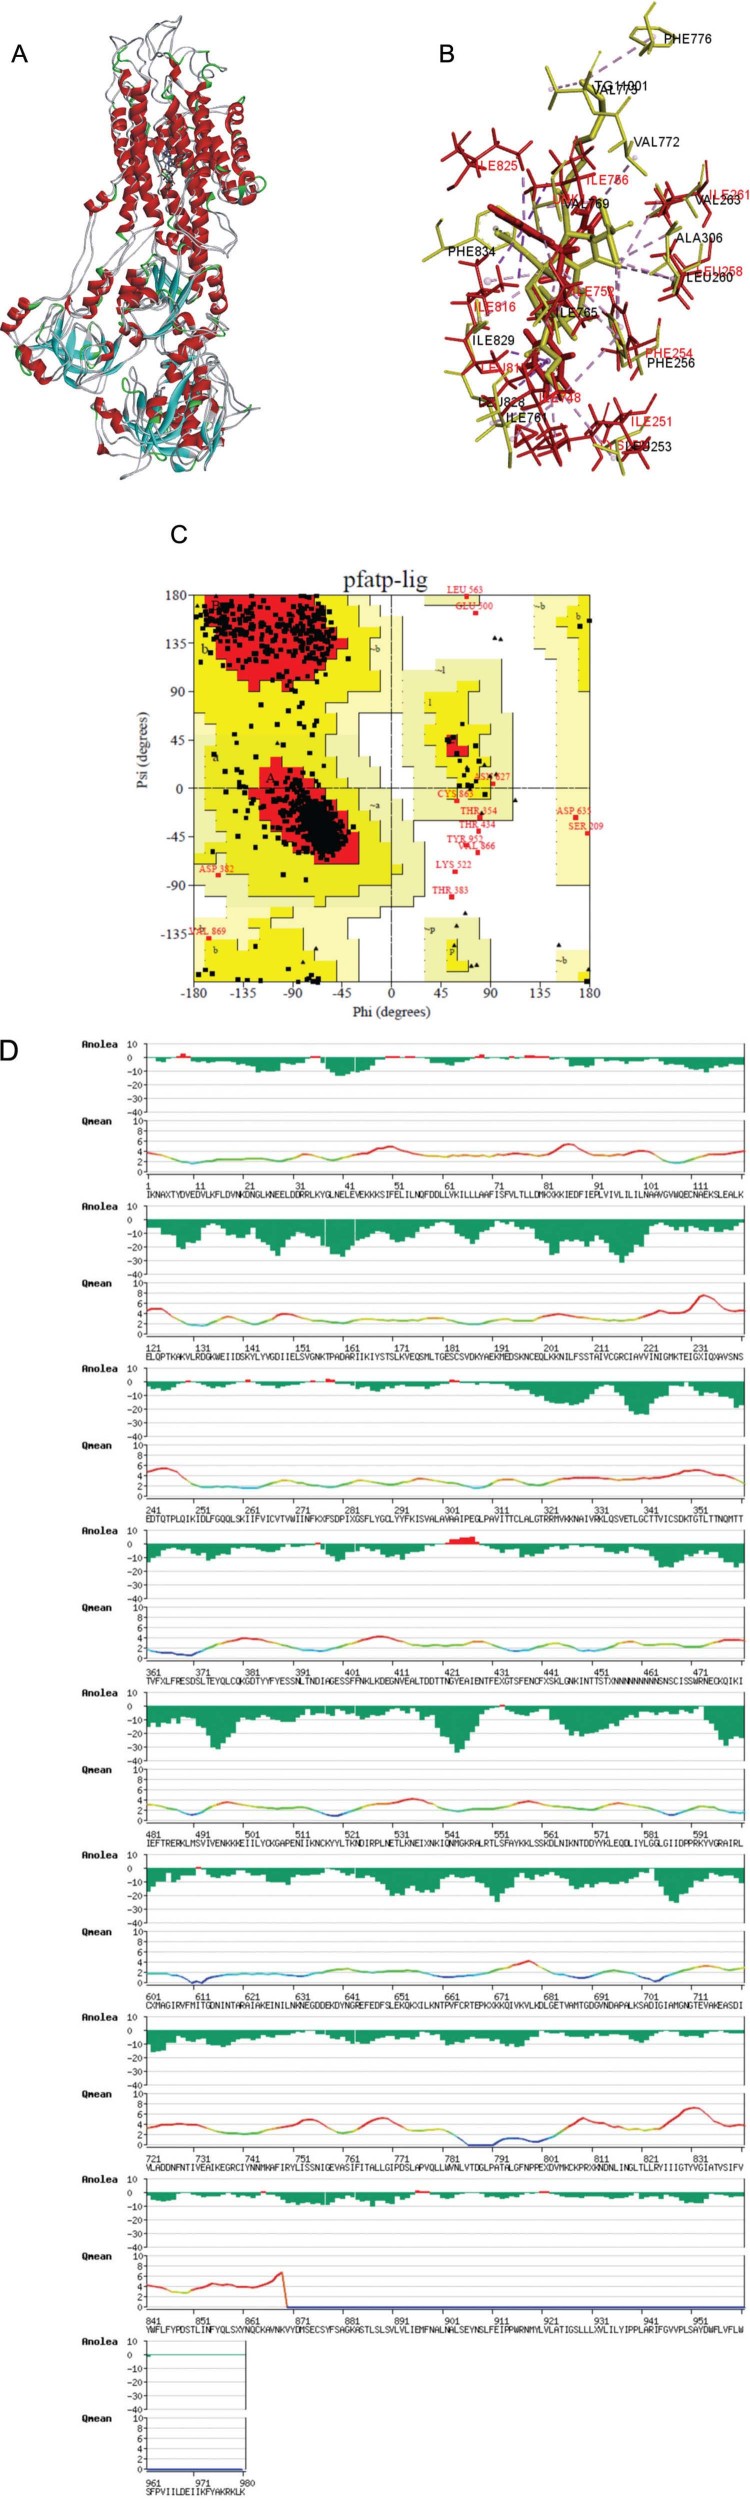
: evaluation of the PfATP6 model. (A) Superimposition of PfATP6 model and
1WIO template; (B) a close view of the binding sites of PfATP6 (red) and 1WIO
(yellow); (C) Ramanchandran plot. Colours red, yellow, and white represent the
most favourable, allowed, and disallowed regions, respectively; (D) Non-local
Atomic Interaction Energy (ANOLEA). The y-axis shows the energy for each amino
acid (aa) of the protein chain. Negative (green) or positive (red) energy
values represent a favourable or unfavourable energy environment of a given aa,
respectively.